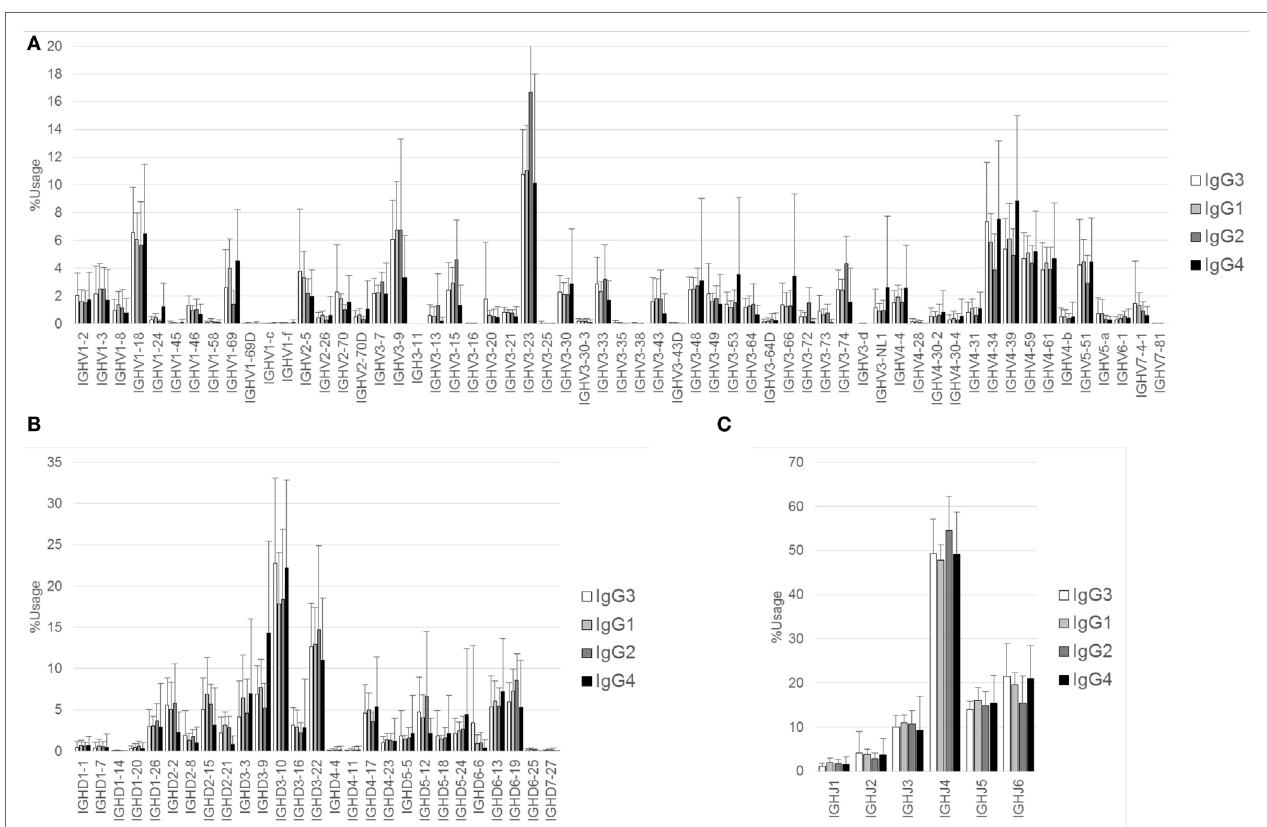
FigUre 2 | comparison of usage of ighV, ighD, and ighJ among igg subclasses . Mean percentage usages of IGHV (a) , IGHD (B) , and IGHJ (c) in IgG3, IgG1, IgG2, and IgG4 are shown. Bars and error bars indicate mean percentage usage and its SD of 12 healthy individuals, respectively. Overall, there were several small differences in the usages of IGHV, IGHD, and IGHJ among IgG subclasses. For IGHV, significant differences were found in IgG3 vs. IgG2 (IGHV3–23, P < 0.01; IGHV4–34,